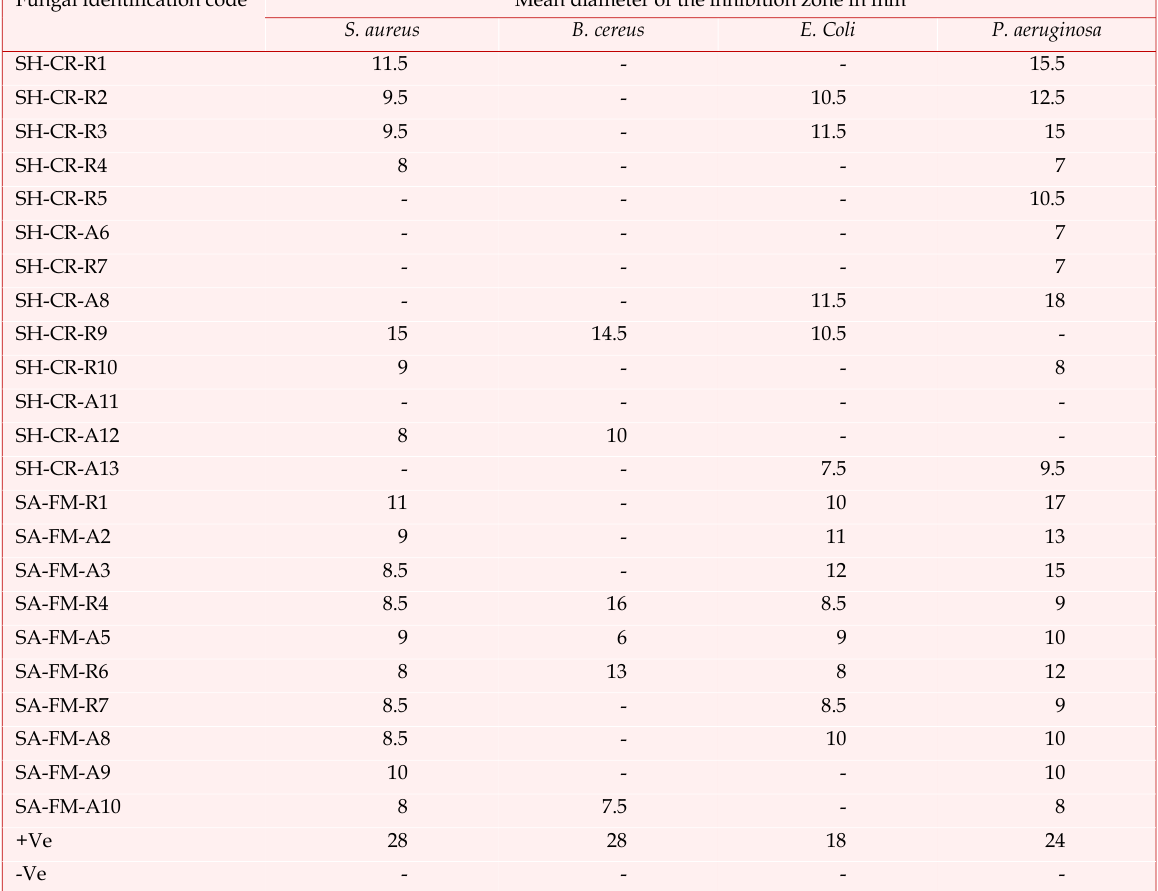
Antibacterial activities of the crudes extracts of endophytic fungi from C. rotundus , and F.miliaceae collected from Badulla at 400 µg/disc concentration